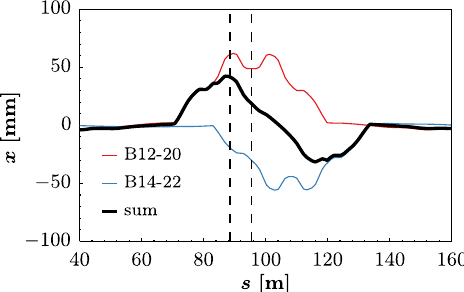
FIG. 22. Simulated horizontal orbit of a core particle at maximum amplitude of the slow extraction bump (black). This orbit is achieved as superposition of the red and blue curves, which represent the two π -bumps created by the dedicated magnets in SS12 and 20, and SS14 and 22, respectively. The locations of TPS15 and SMH16 are indicated by the dashed